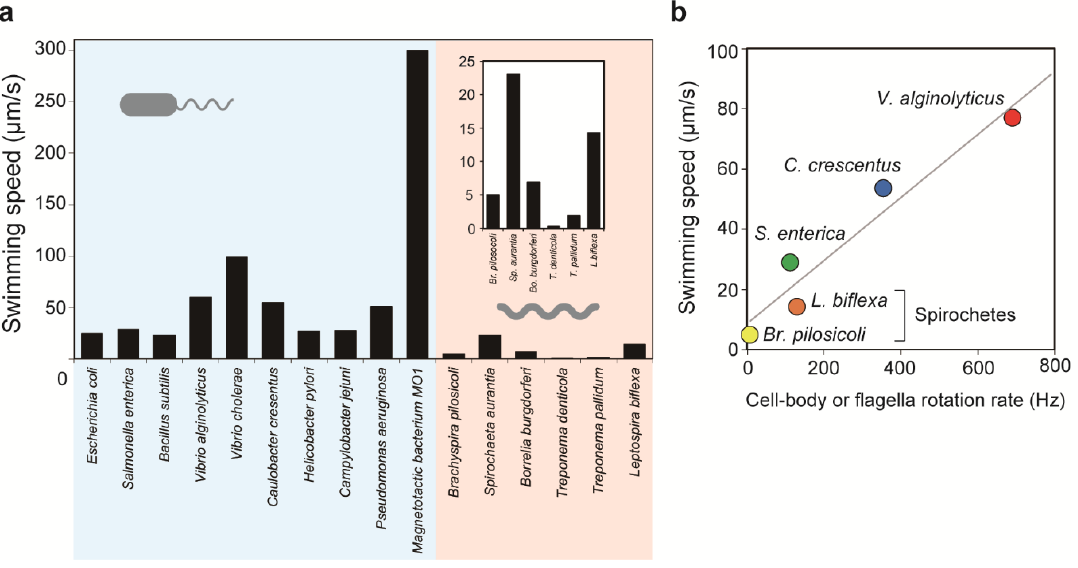
Figure 3. Speeds of bacterial motility. ( a ) Swimming or gliding speeds of various bacterial species. Spirochete-derived data are enlarged in the inset. Refer to the following literature for the corresponding swimming measurements: E. coli [65], S. enterica [74], B. subtilis [49], V. alginolyticus